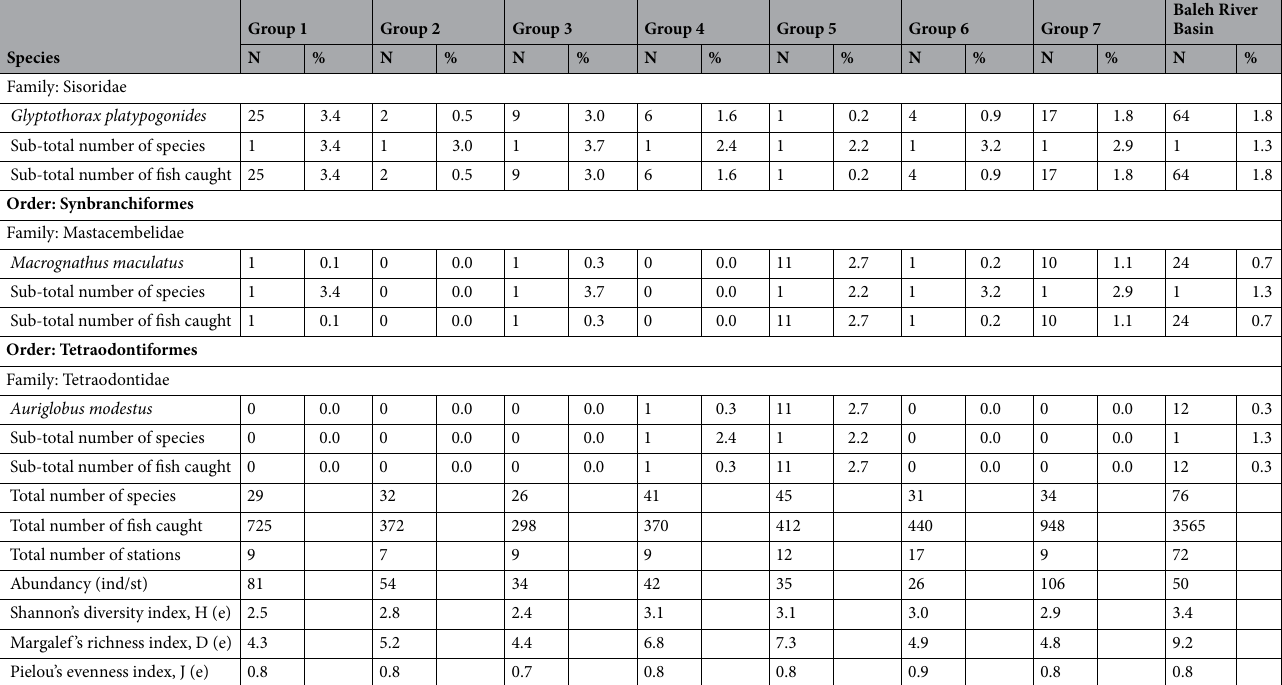
Table 2. Summary of the fish composition and metrics of diversity in the Baleh River Basin.